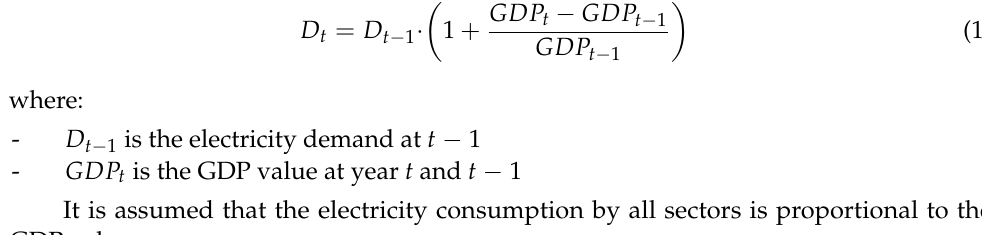
Figure 4. Estimated electricity load fraction per time-slice at daily level in 2018.